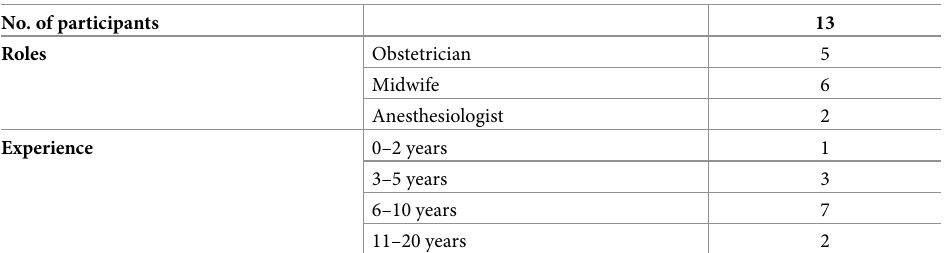
Table 2. Participants’ roles and